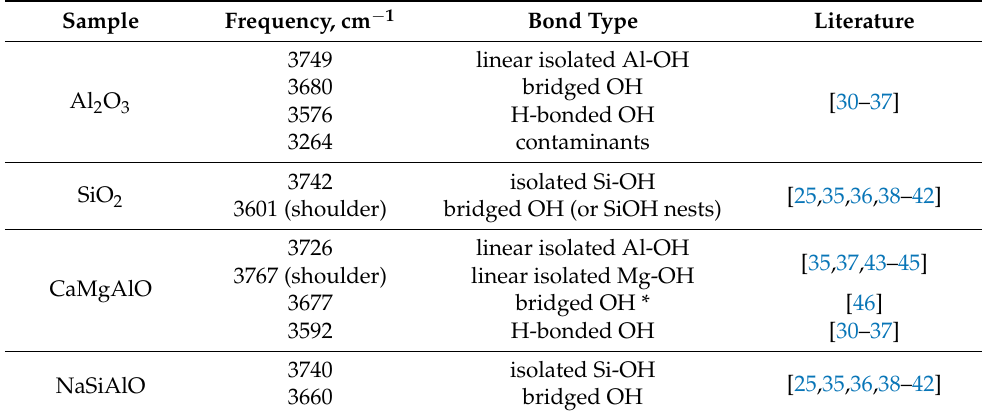
Table 3. The shifts of stretching vibrations of CN groups upon interaction with CD 3 CN (strong base)